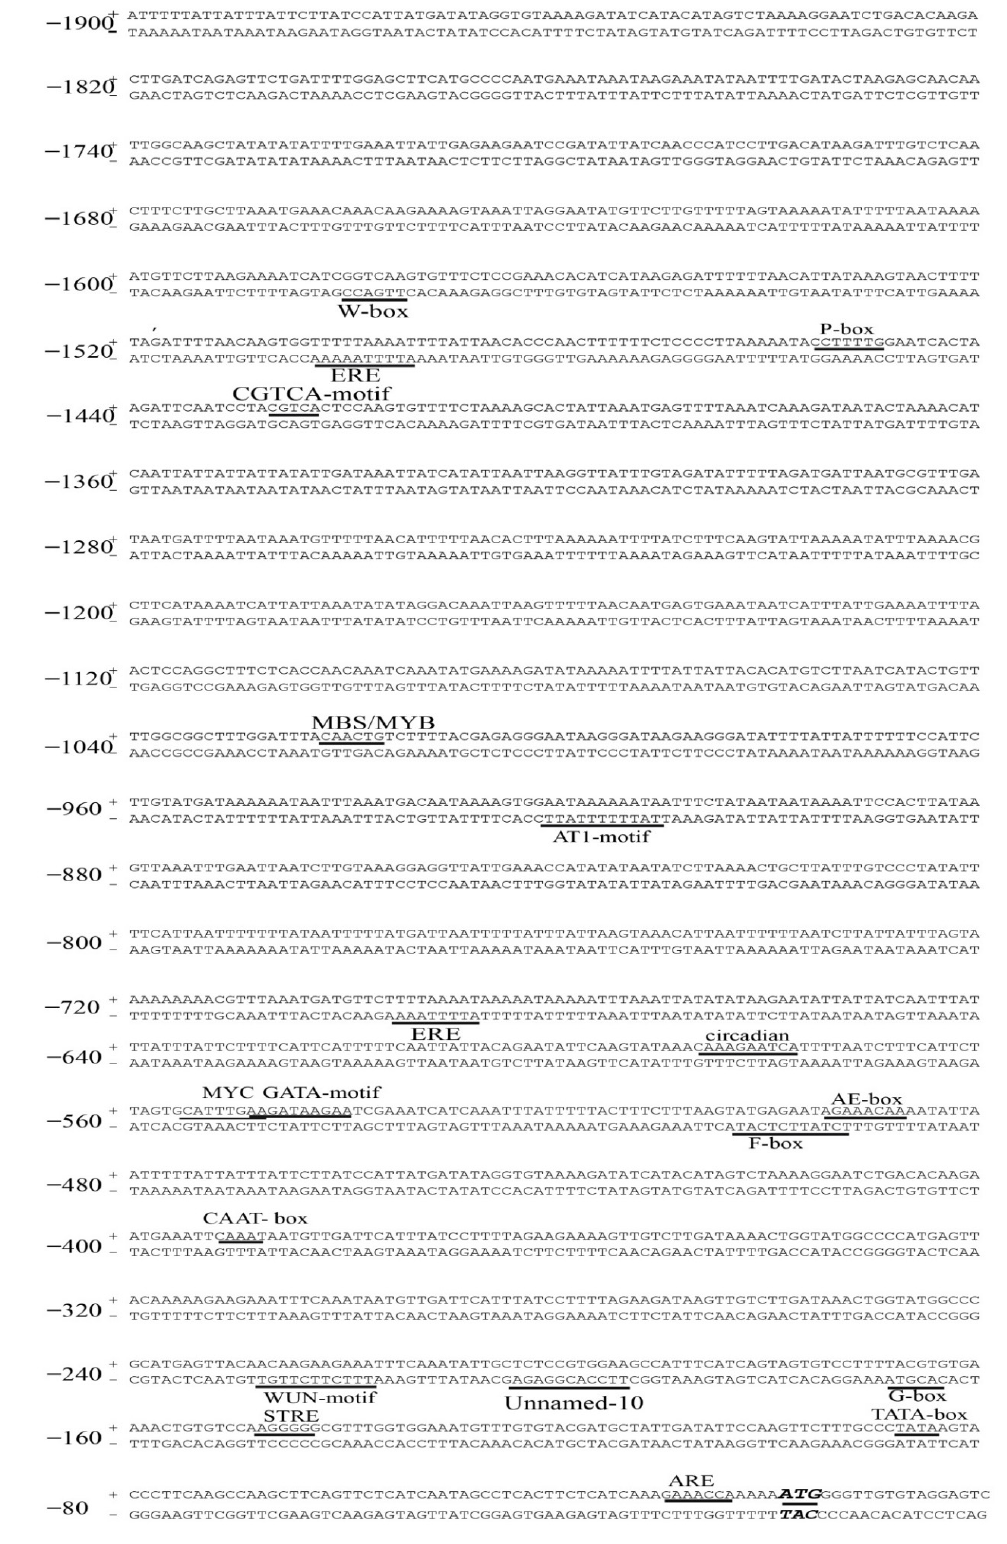
Figure 5. The 5 ′ upstream nucleotide sequence starting from the transcription start site of the VvPR1 gene containing the putative promoter and predicted cis ‐ acting elements. The underlined